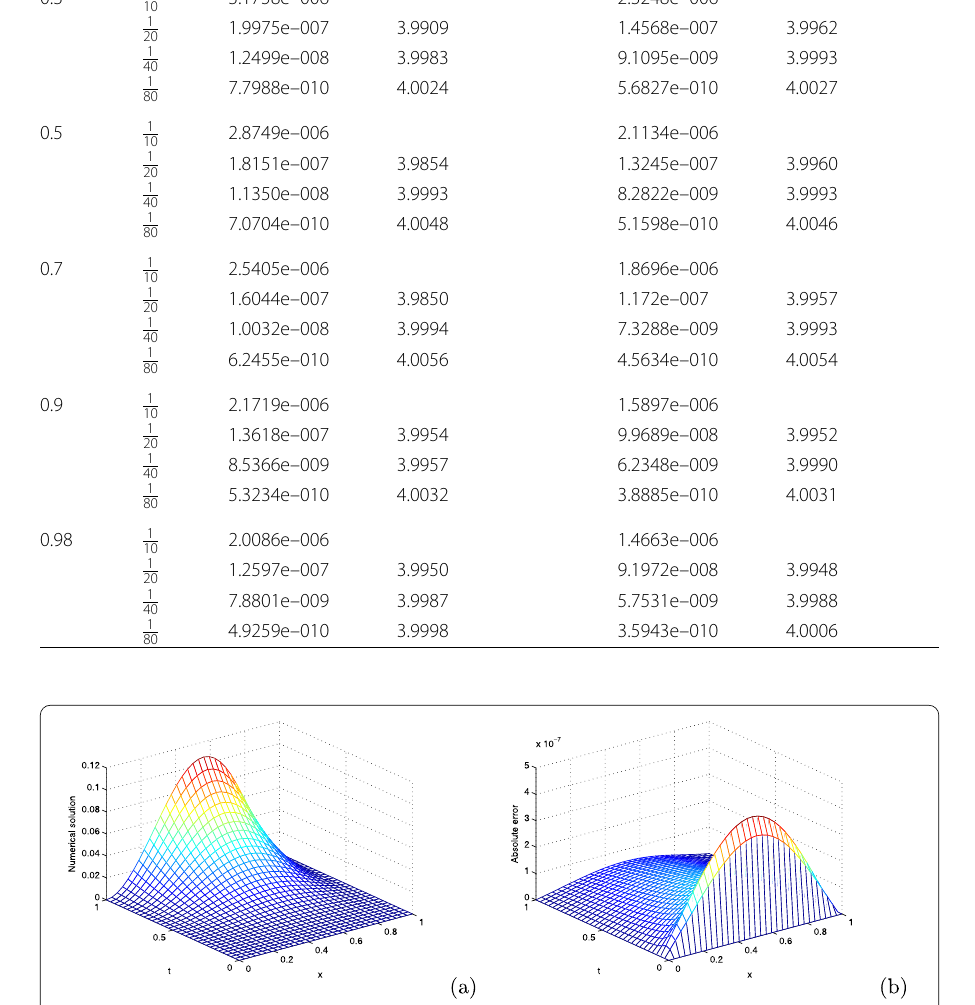
Figure 1 Numerical solution ( a ) and global error ( b ) for Example 1 with α = 0.5, h = 1/32, τ = 1/32